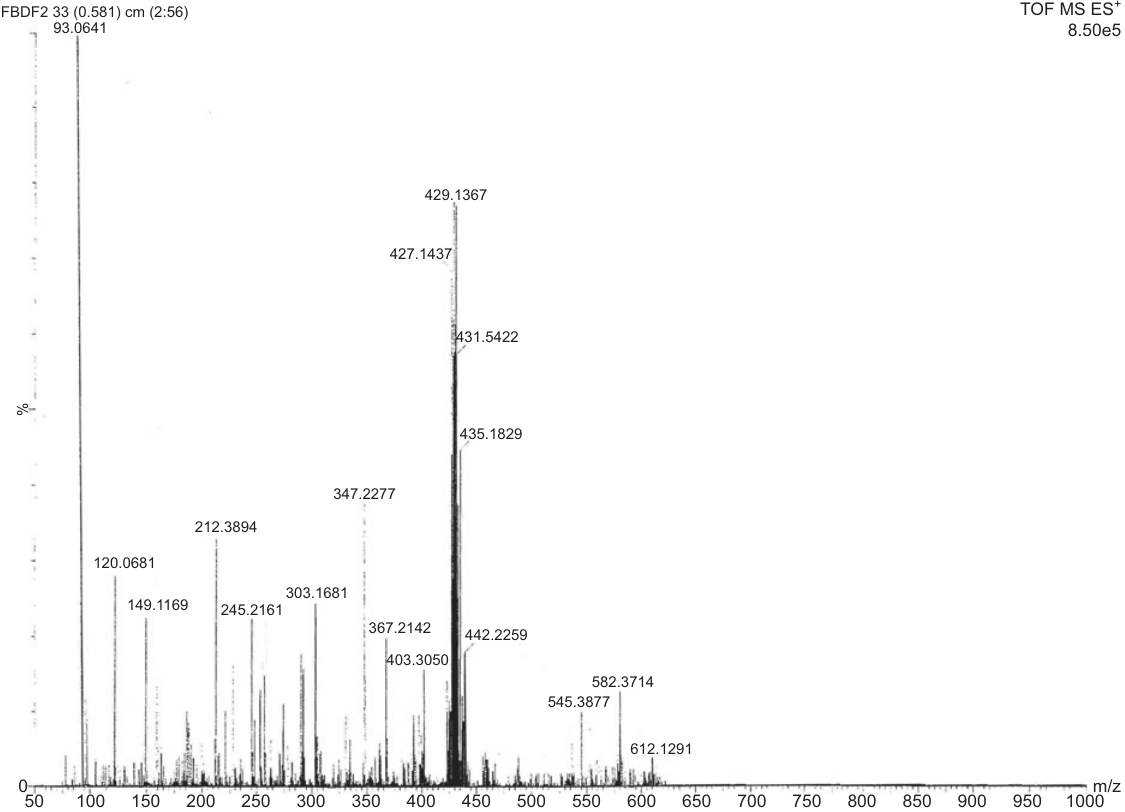
Figure 2 TOF-MS spectrum of [SnCl